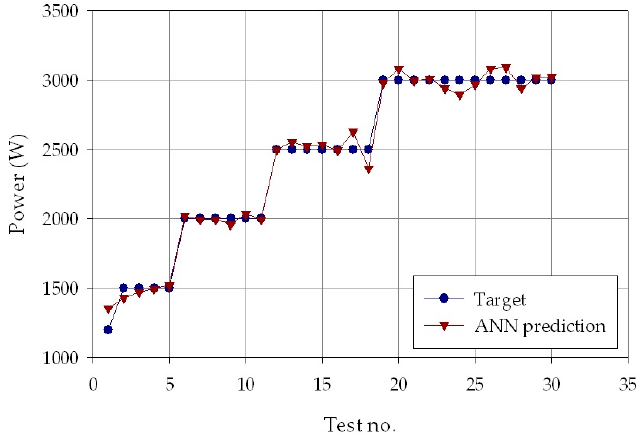
Figure 6. Experimental (blue marks) and ANN estimated (orange marks) power values, P , for each of the p = 30 experimental conditions.